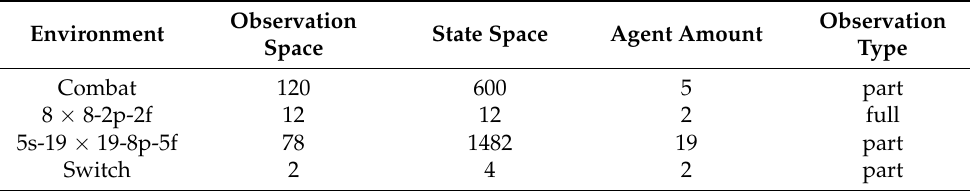
Table 1. Detailed Information of Environments in